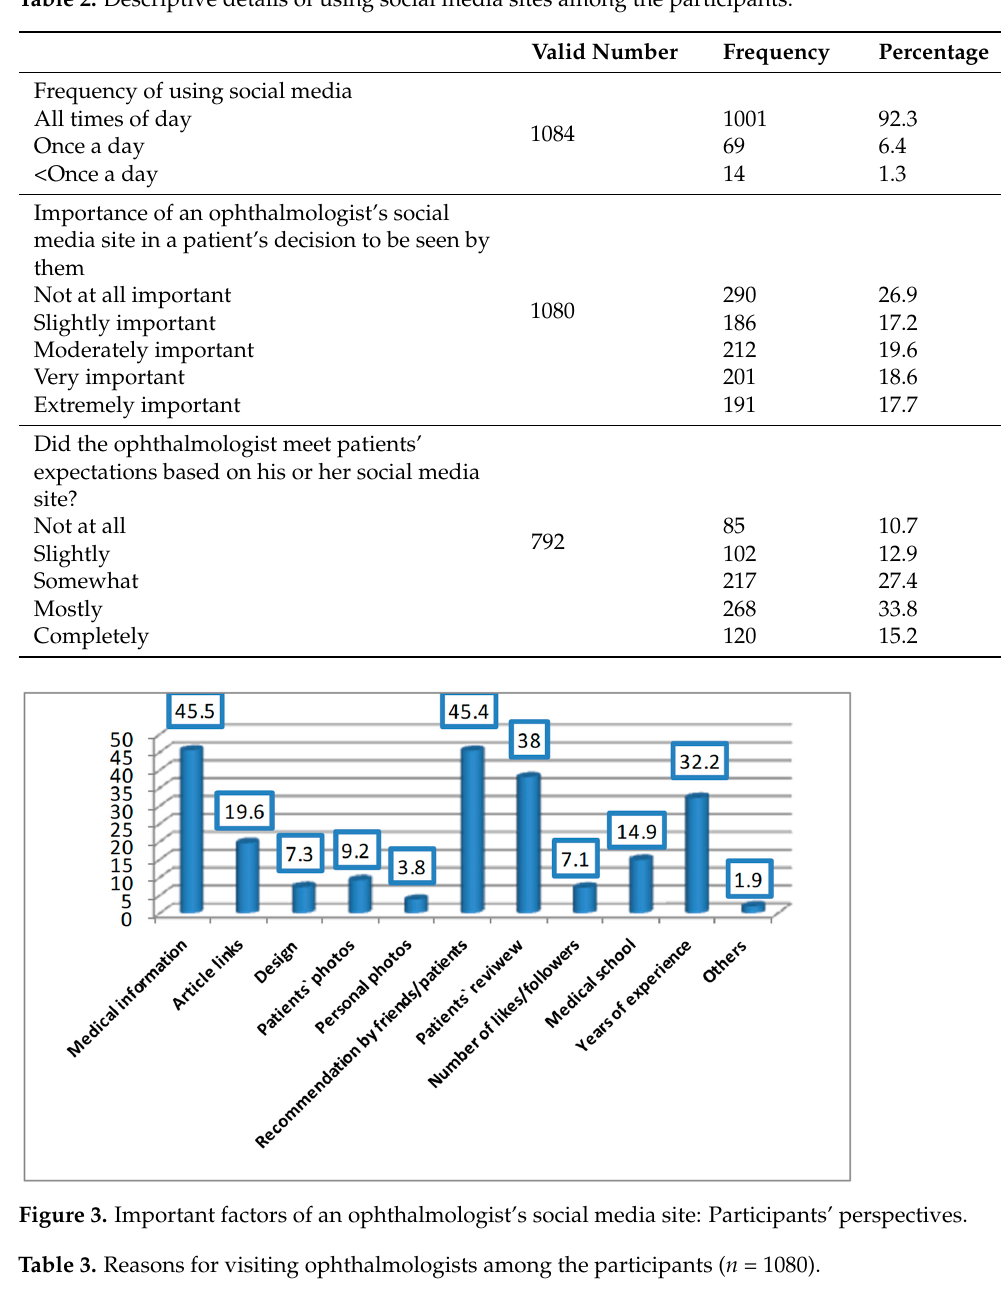
Table 2. Descriptive details of using social media sites among the participants.